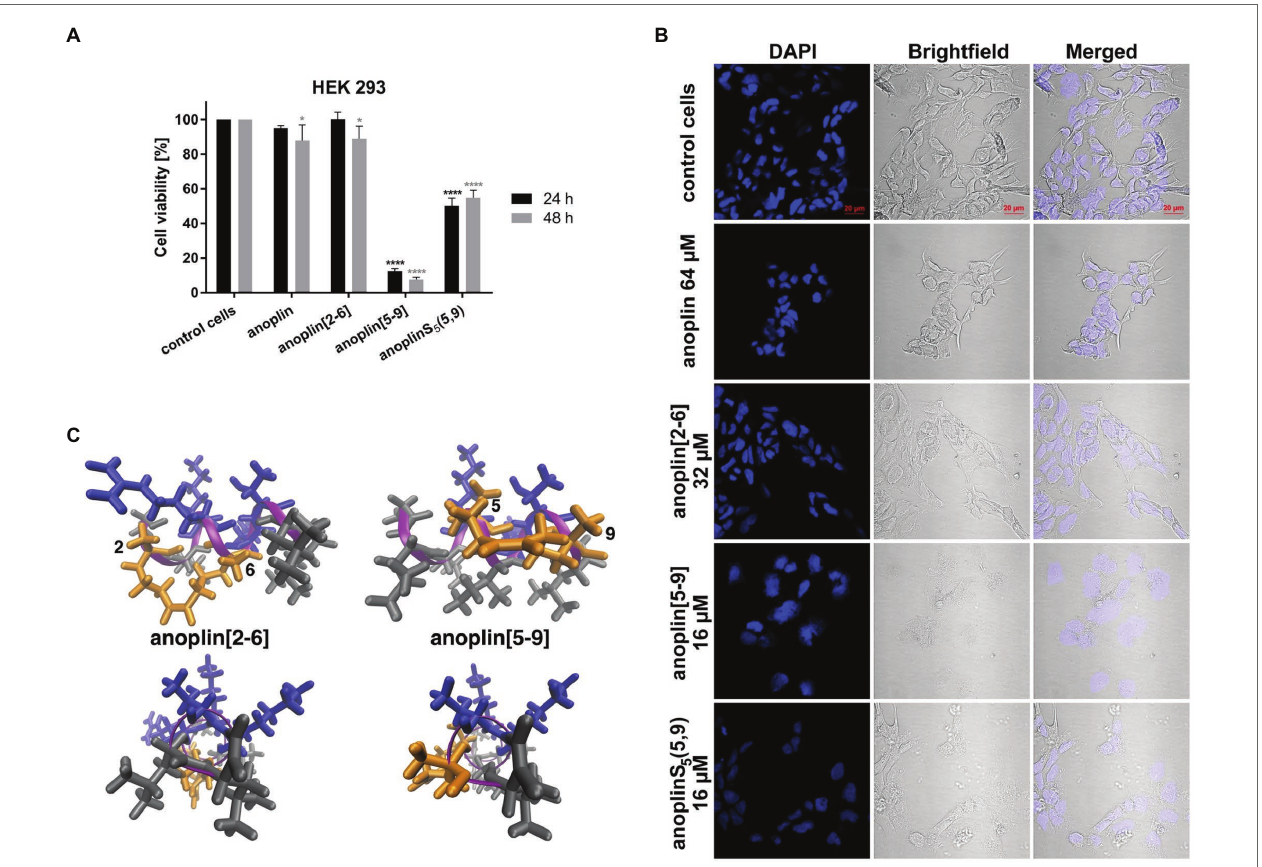
FIGURE 3 | (A) The cytotoxic effect on HEK 293 cells of anoplin analogs at the concentration of 32 μ M. The results are presented as the % cell viability in comparison with untreated control cells. Error bars represent the standard error of the mean; n = 3. Statistical significance between samples and untreated cells: **** p < 0.0001 and * p < 0.05. (B) Confocal microscope images of the HEK 293 cells, counterstained with DAPI, untreated or incubated with indicated concentrations of anoplin, anoplin[2-6], anoplin[5-9], and anoplinS 5 (5,9). Scale bars equal to 20 μ m. (C) The structures of stapled anoplin[2-6] and anoplin[5-9] showing the polar and non-polar residues (side and top views). Peptide main chains are indicated in pink. Hydrophobic residues are shown in gray and hydrophilic in blue. Orange represents the hydrophobic hydrocarbon staples.